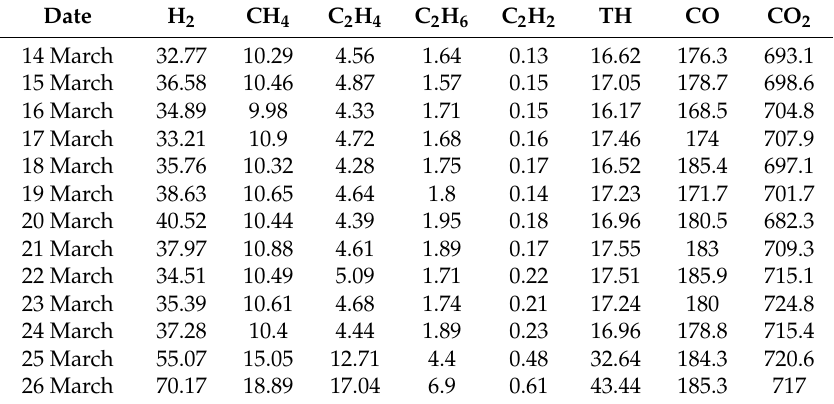
Table 4. Oil chromatography online monitoring data for the 500 kV #2 transformer (units: µ L/L).